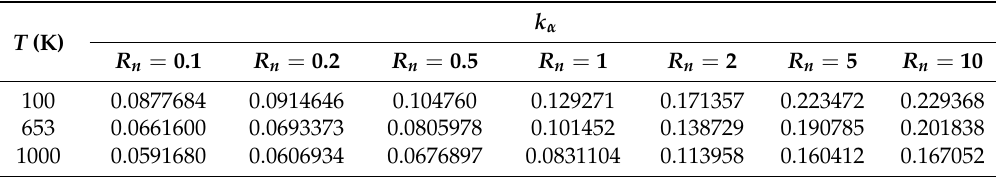
Figure 2. Convergence of w ( L /2,2 π /2 ) (mm) versus N = M for L / h ∗ = 5 and L / R = 2. Table 1. Varied shear correction coefficient k α versus R n and T for h ∗ = 1.2